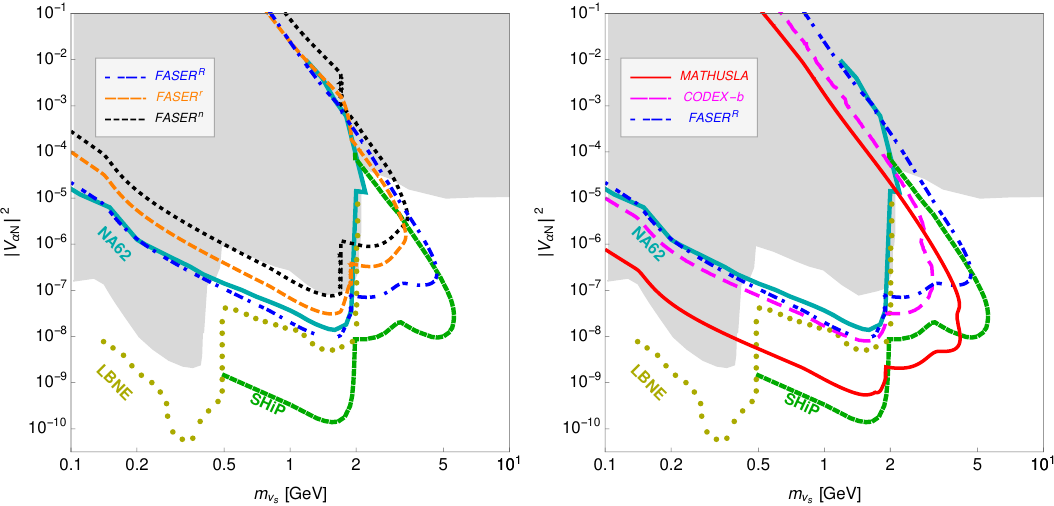
Figure 4 . Sensitivity estimates in the plane mixing angle squared, j V (cid:11)N j 2 versus mass of the sterile neutrino, m (cid:23) [GeV]. To the left we compare the di(cid:11)erent variants of FASER, to the right FASER R , S CODEX-b and MATHUSLA compared to LNBE and SHiP. For a discussion see